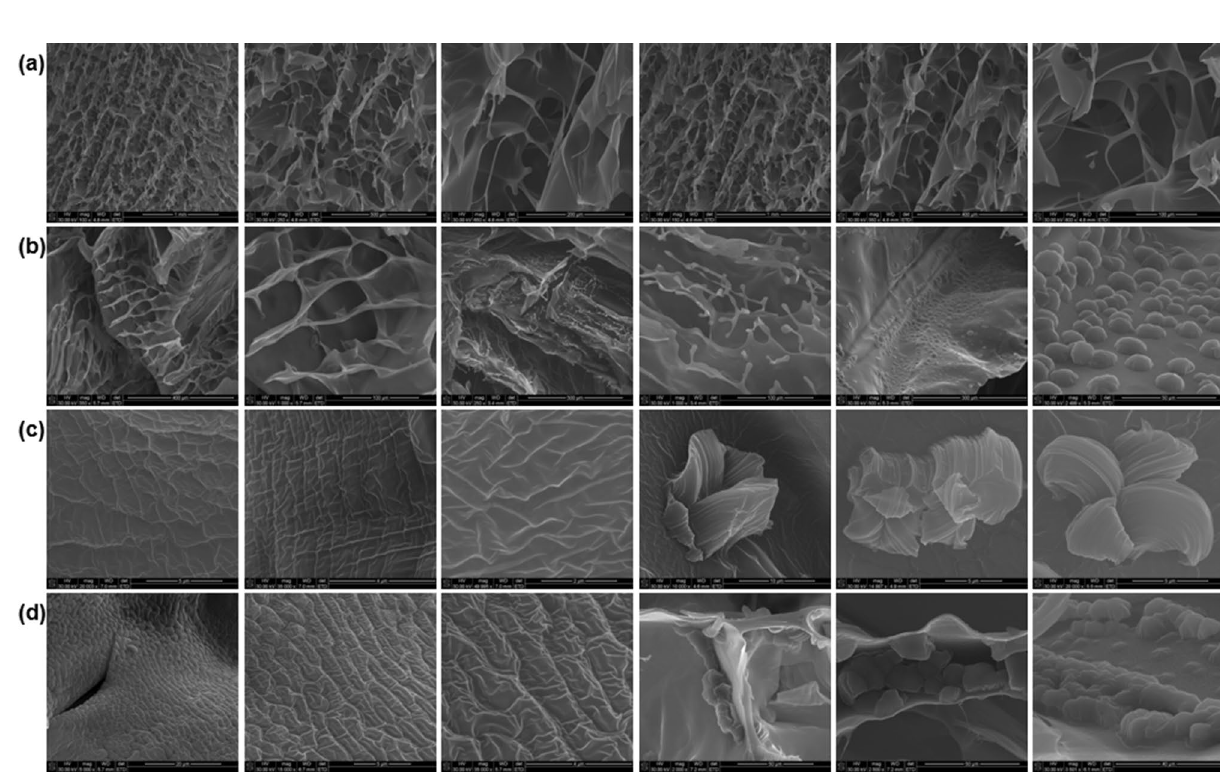
Figure 4. Scanning electron micrographs of ( a ) CHT; ( b ) CHT-mPEG; ( c ) CHT-mPEG-CHO; and ( d ) CHT- mPEG-COOH cryosponges representing surface characteristics and unique features of the porous